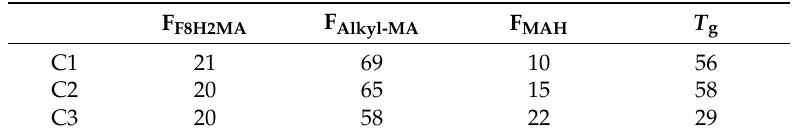
Table 11. Composition and glass transition temperatures (second heating) of ternary copolymers obtained in continuous addition experiment. Composition according to elemental analysis. F F8H2MA F Alkyl-MA F MAH T g C1 21 69 10 56 C2 20 65 15 58 C3 20 58 22